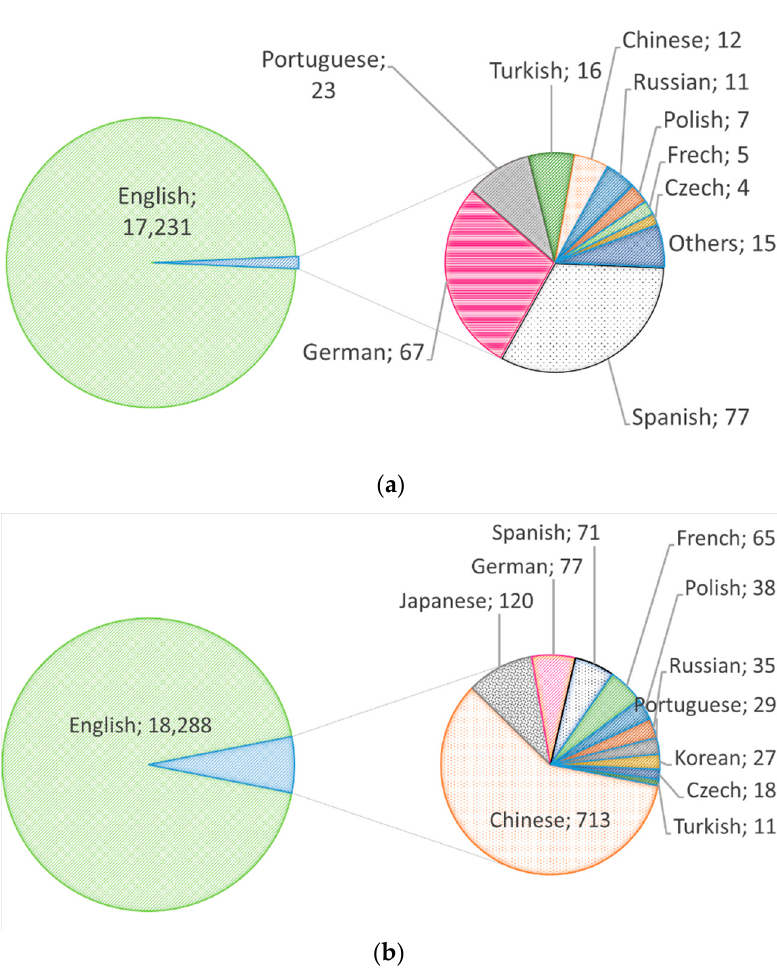
Figure 2. Distribution by language of documents published during the period January 2013–September 2019: ( a ) Web of Science; ( b ) Scopus.